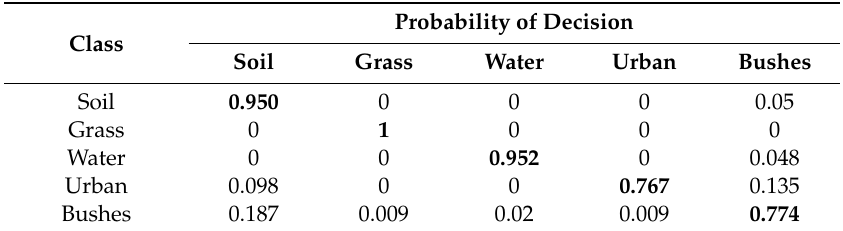
Table 18. Classification probabilities for the NN-based method trained for the original image and applied to it.